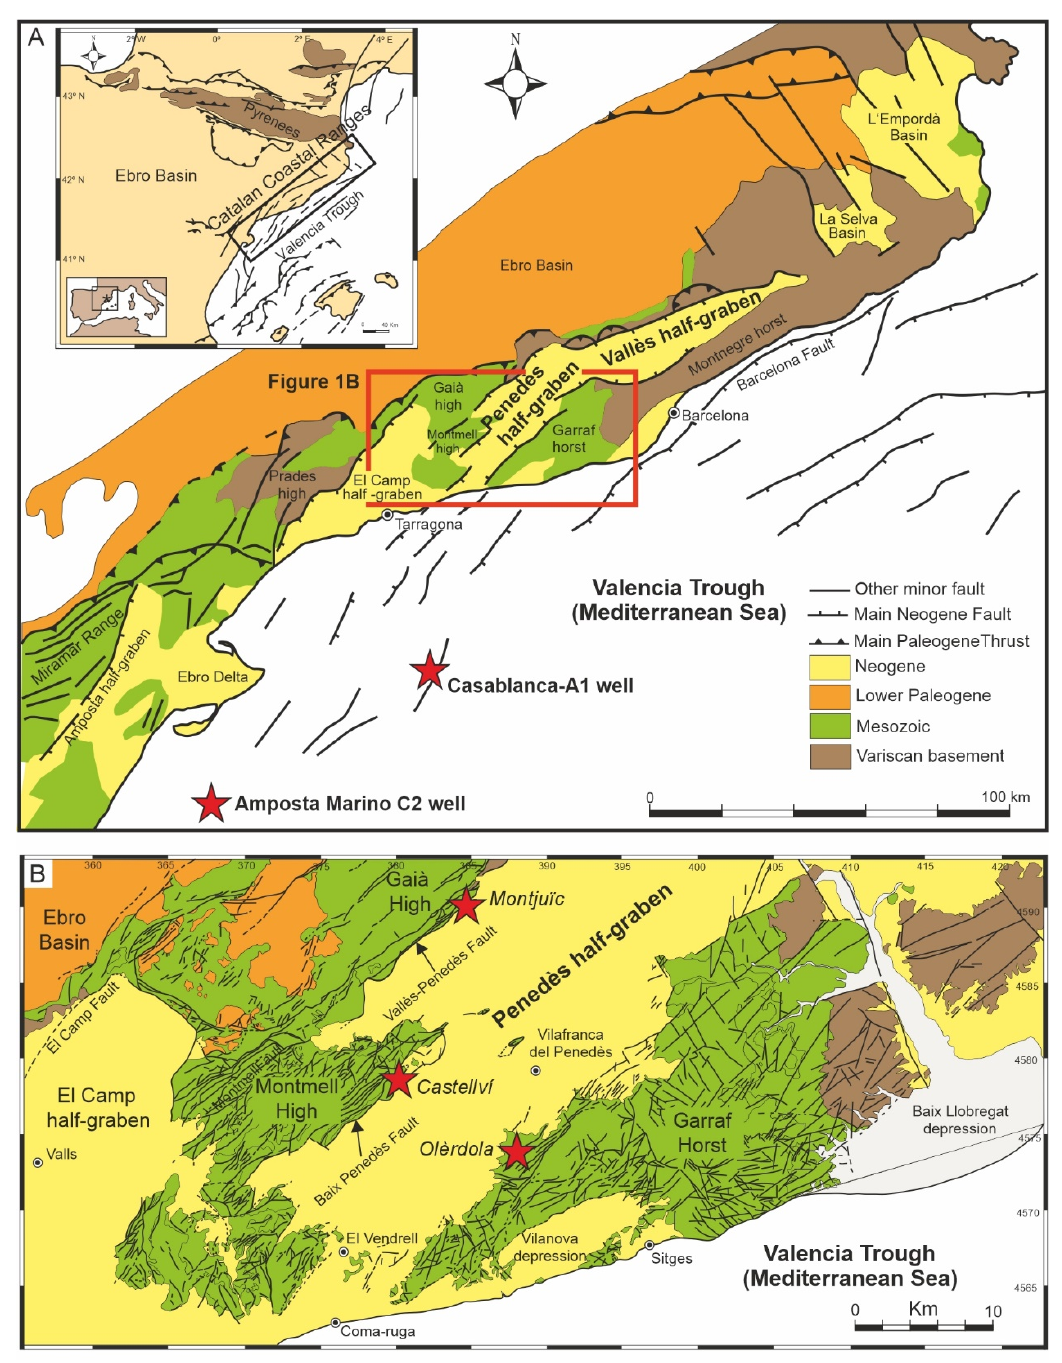
Figure 1. ( A ) Simplified geological map of the Catalan Coastal Ranges and location of the Casablanca-1A and Amposta Marino C2 wells in the València Trough (red stars). The red box indicates the location of Figure 1B. ( B ) Geological map of the Penedès half-graben showing location of the Castellví, Olèrdola and Montjuïc outcrops (red stars). Redrawn from [3].